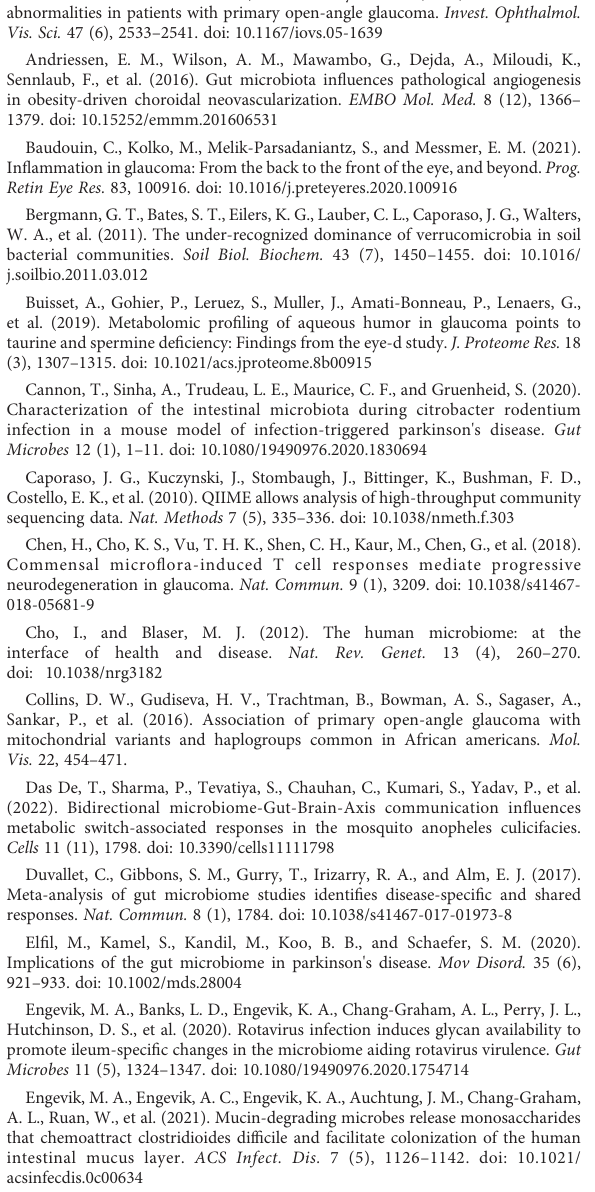
SUPPLEMENTARY FIGURE 1 Venn diagram representation of the shared and exclusive OTUs in glaucoma and control groups. OUT, operational taxonomic